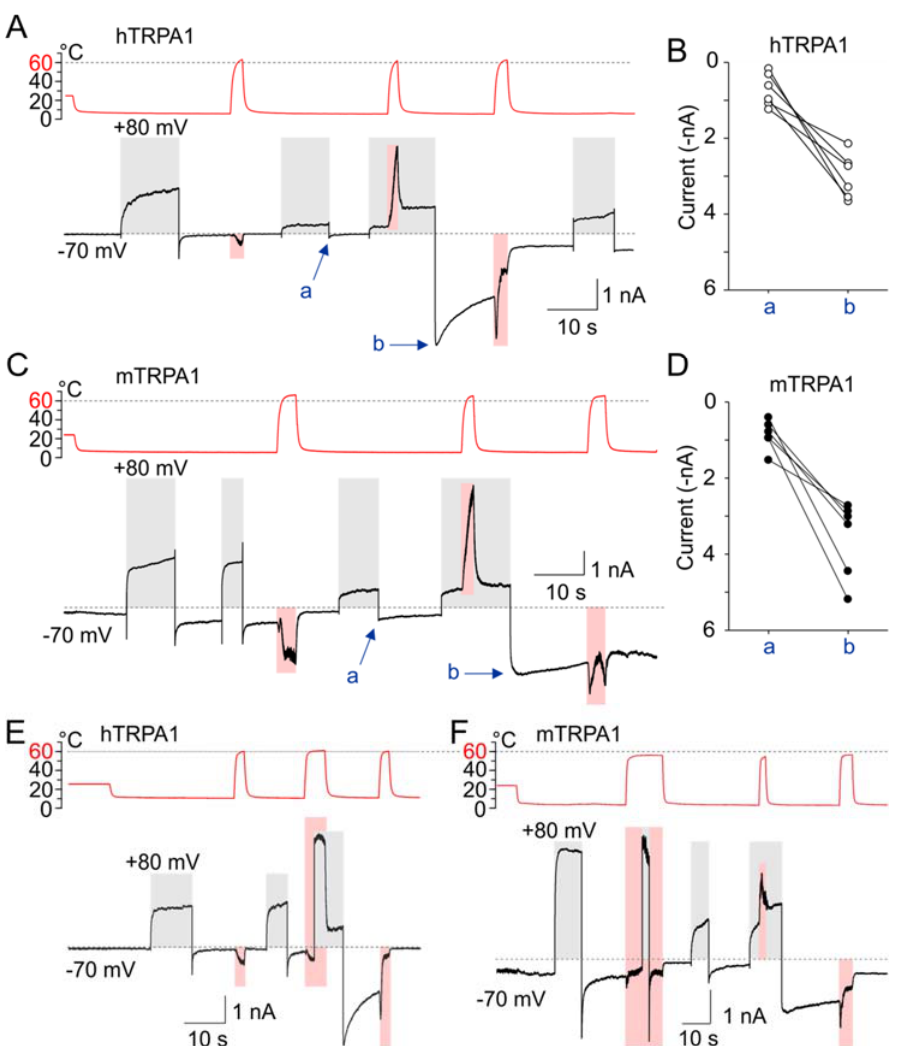
Figure 7. Concurrent activation of voltage- and heat-sensor renders the TRPA1 channel cold-sensitive. ( A ) Representative whole-cell currents of hTRPA1 in response to temperature (shaded pink area) and voltage (shaded grey area) steps. The temperature trace is shown above the records. The current-to-temperature relationship of the first heat response is shown in Figure S8A,B. Exposure to depolarization concurrently with excessive heat rendered the TRPA1 channels dramatically cold-activated (arrow b) once back at negative membrane potentials, as compared to inward current (arrow a) after exposure to only depolarization. ( B ) The increase in inward currents for individual cells expressing hTRPA1 ( n = 6), measured at times indicated by arrows in ( A ). ( C ) Representative whole-cell currents of mTRPA1 treated like those in ( A ). ( D ) The increase in currents for six individual cells expressing mTRPA1 measured at times indicated by the arrows in ( C ). ( E ) Representative whole-cell currents of hTRPA1 treated similarly to those in ( A ). The cold-induced inward currents were produced independently of whether depolarization or heat was applied prior to the concurrent activation of both sensors. ( F ) Representative whole-cell currents of mTRPA1 treated similarly to those in ( A ). Note the di ff erence in inward current after depolarization during noxious heat exposure or after noxious heat exposure during